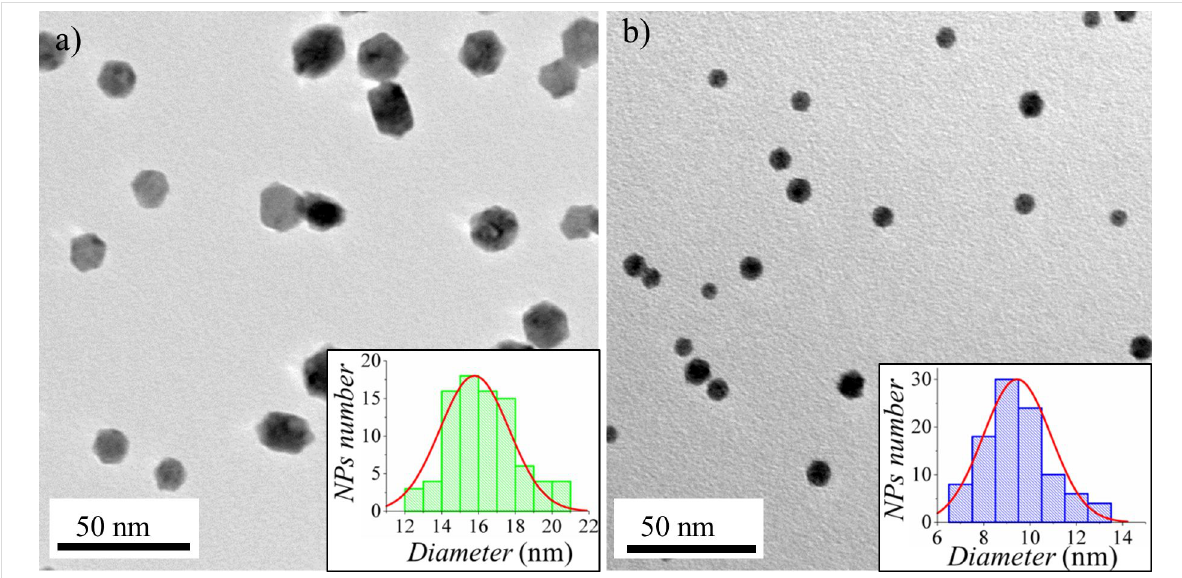
Figure 1: TEM image of the as deposited Hf nanoparticles with mean sizes of (diameter × height) a) 16 nm × 15 nm (aggregation-zone length D = 100 mm); b) 9.5 nm × 7 nm (aggregation-zone length D = 50 mm). The inset shows a histogram with the diameter distribution. In both cases faceted NPs are